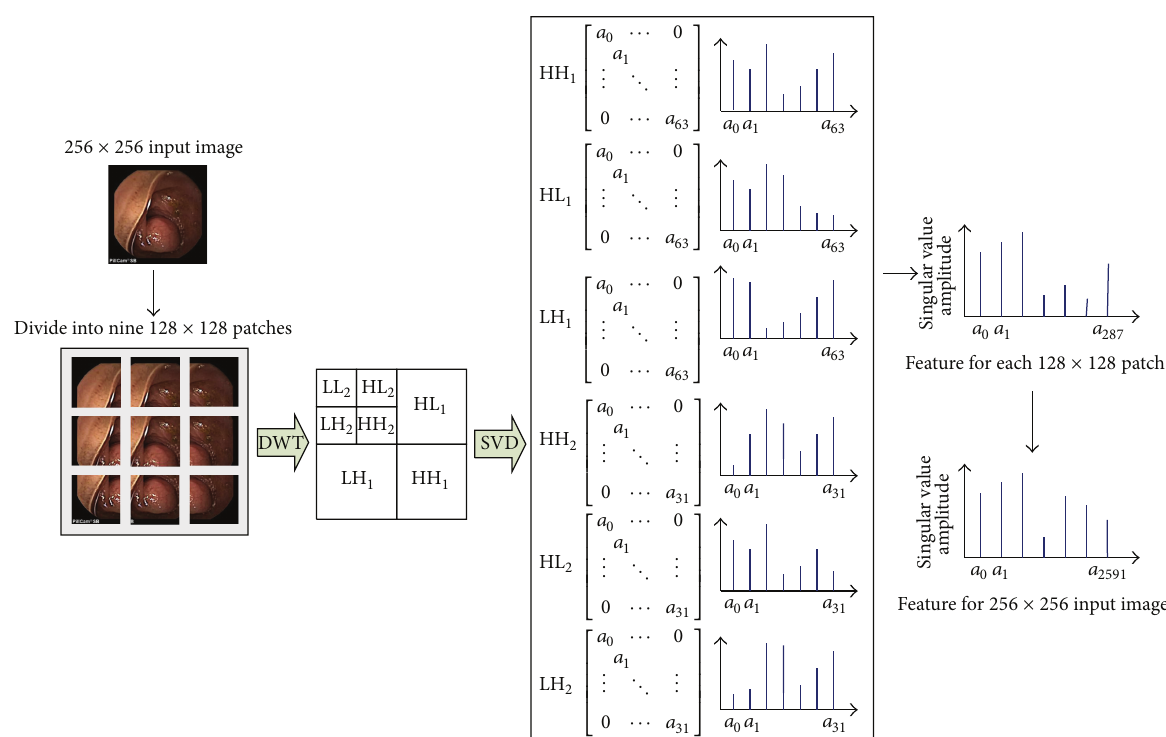
Figure 6: The process for extracting SVD based color texture feature using two-level DWT.